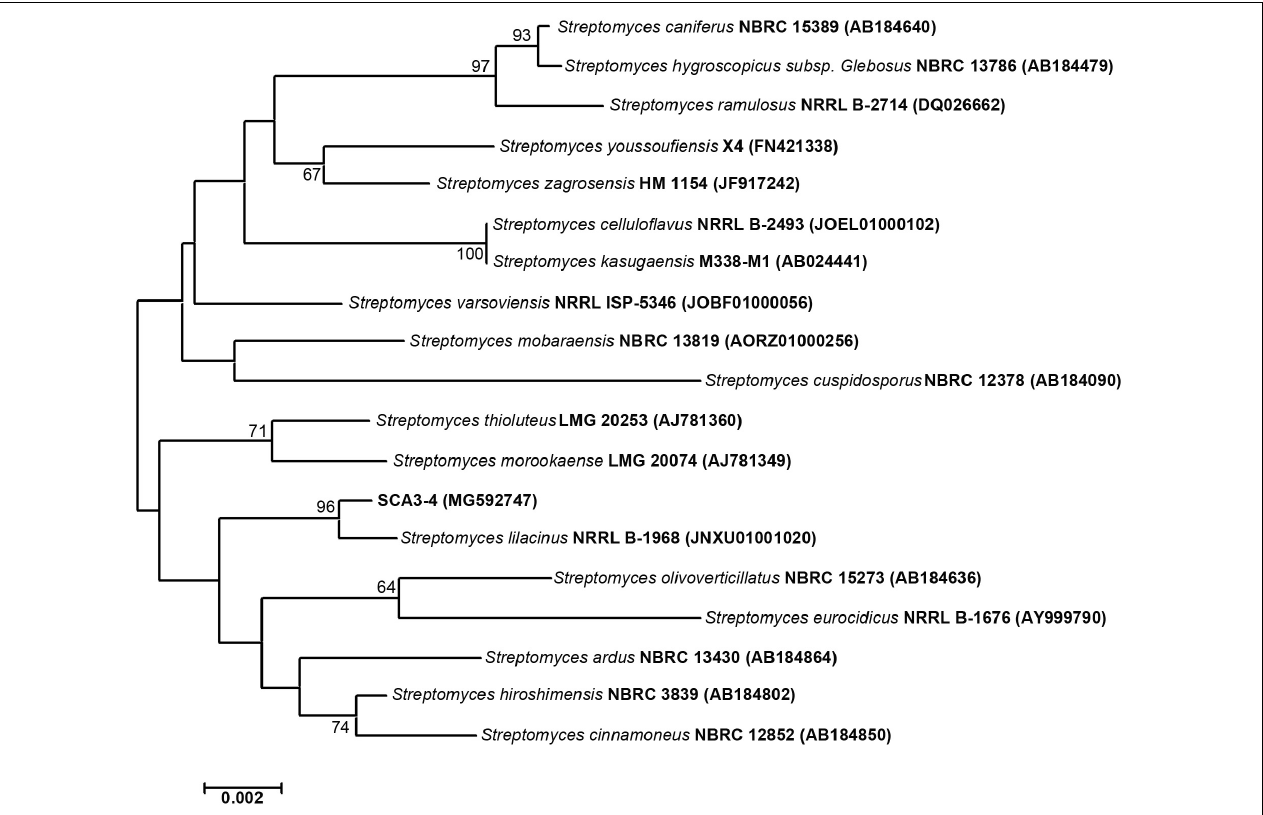
FIGURE 3 | Construction of phylogenetic tree based on the 16 S rRNA sequences from strain SCA3-4 and other selected strains. The phylogenetic tree was constructed using the neighbor-joining method. Numbers on the branches are bootstrap values calculated from 1,000 replicates. Bar, 0.002 substitutions per nucleotide